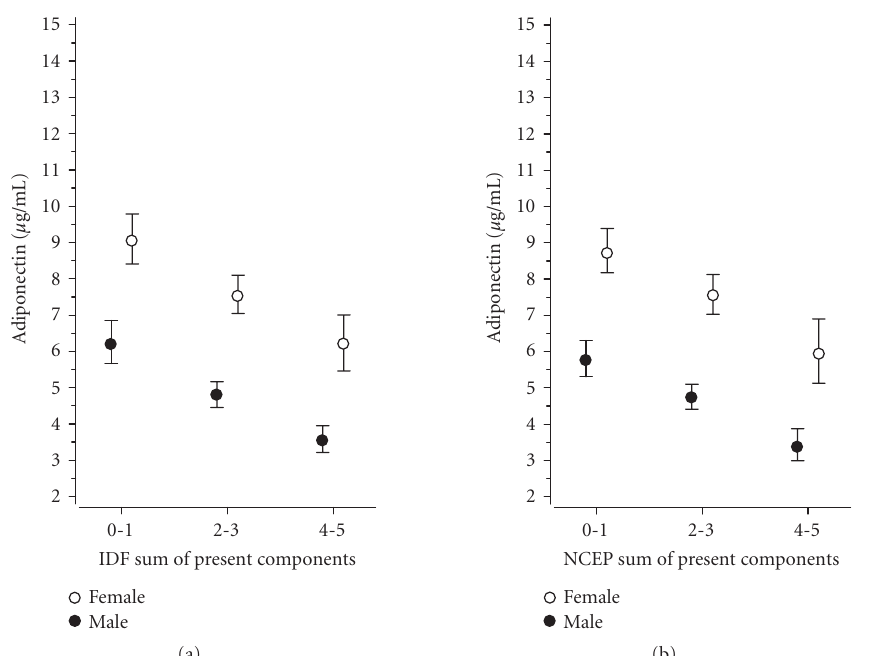
Figure 1: Relationship between adiponectin and the number of the components of the metabolic syndrome according to the IDF and NCEP criteria (95% confidence intervals obtained by bias-corrected and accelerated bootstrapping (5000